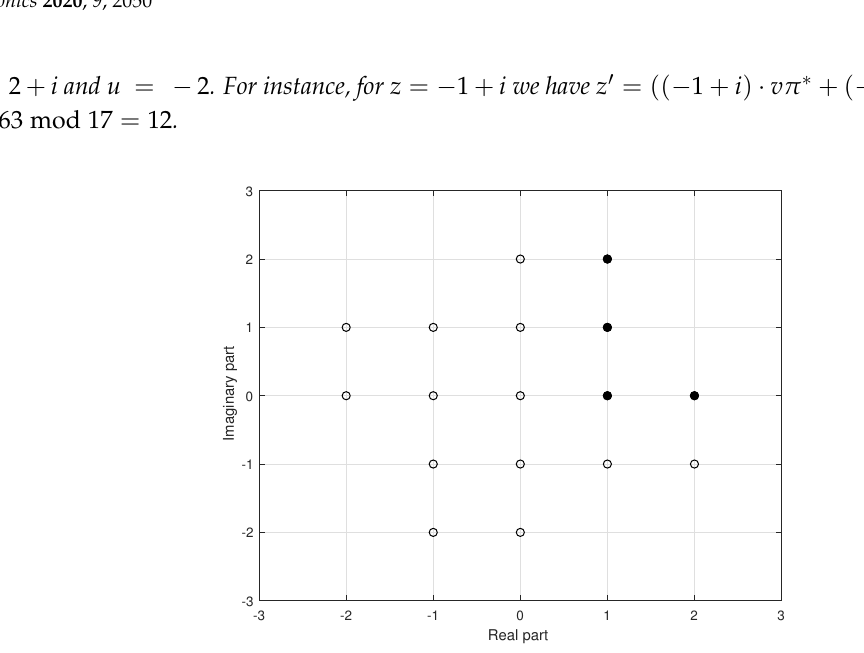
Figure 1. The set of Gaussian integers for π = 4 + i